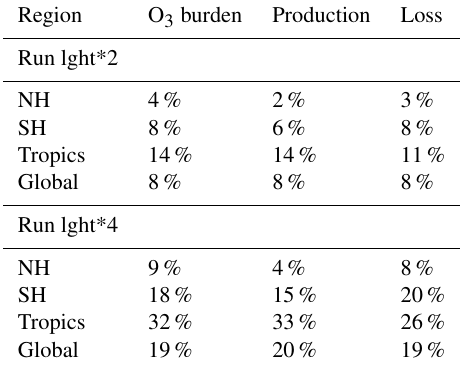
Table 6. Percent changes in ozone budget terms in the Northern Hemisphere, the Southern Hemisphere, and the tropics of the simu- lations lght*2 and lght*4 versus the base run. The latitude boundary of the tropics was chosen at 20 ◦ N or S. Region O 3 burden Production